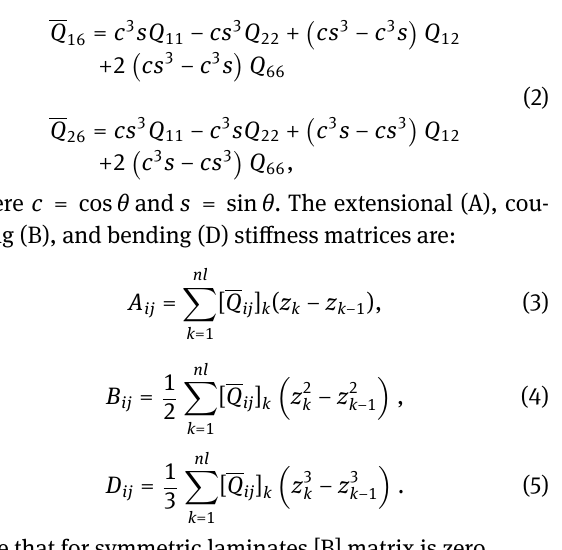
servative estimate of the ultimate buckling resistance of the plate in question. As a result, the selection of critical buckling load extracted from experimental load versus the out-of-plane displacement diagram is not well defined. In this work the critical buckling load was extracted at the in- tersection of tangents to the postbuckling section and ini- tial stiffness line of the diagram as will be discussed